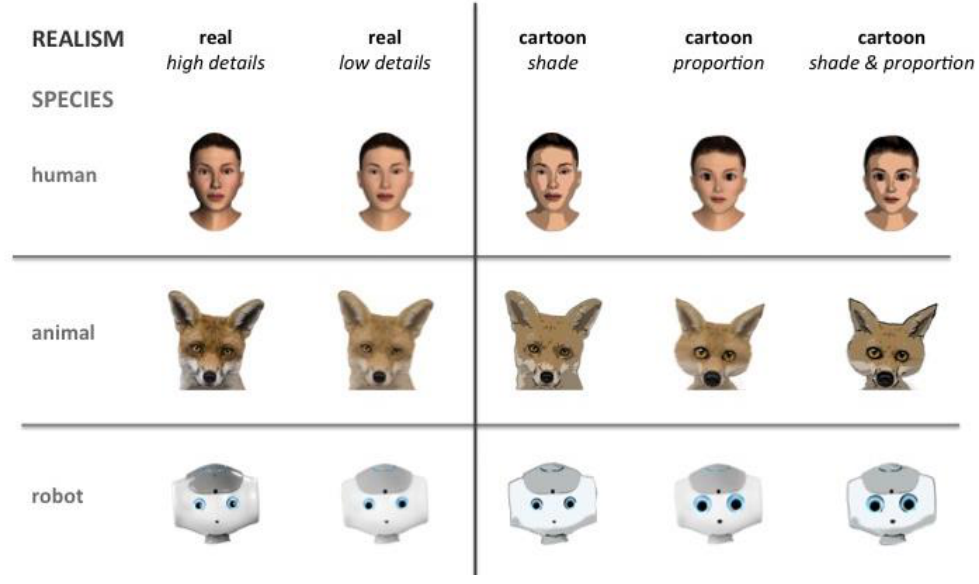
Figure 2. Examples of the used stimulus material.